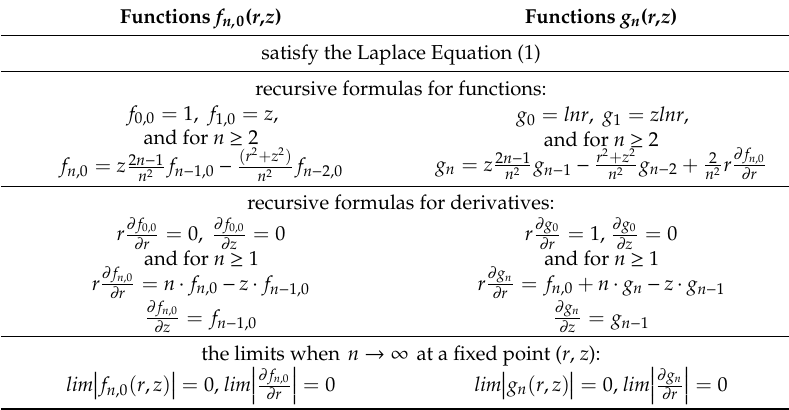
Table 1. Properties of T-functions f n, 0 ( r , z ) and g n ( r , z ). Functions f n, 0 ( r , z ) Functions g n ( r , z